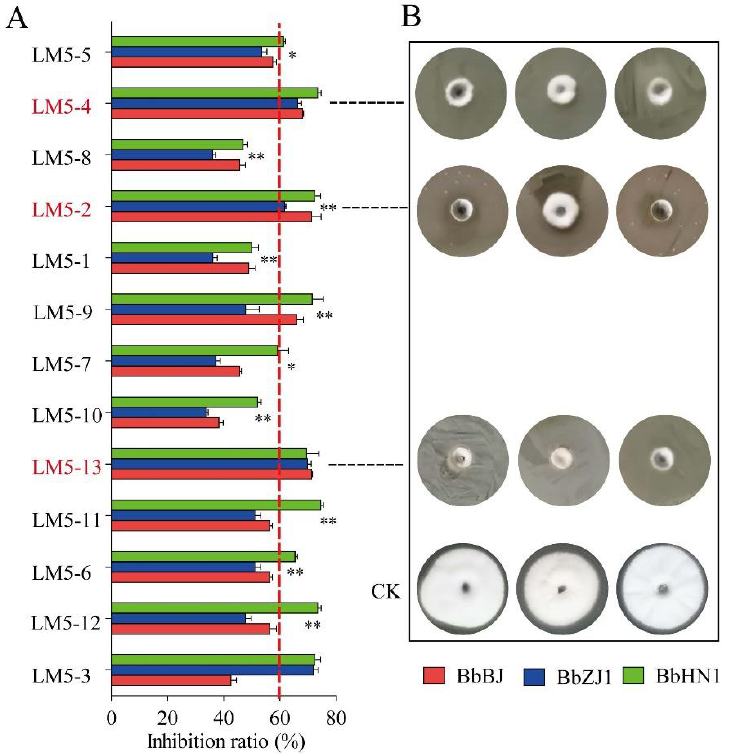
Figure 2. Inhibitory effect of migratory locust surface bacterium on B. bassiana . ( A ) Inhibition rates for B. bassiana strains by bacteria. Values (mean ± SE) with “*” or “**” are significantly different between strain BbZJ1 and other strains at a level of 0.05 or 0.01 (Kruskal – Wallis test). ( B ) B. bassiana colonies growing on medium coated with three of the recovered bacterial strains. CK: normal-growing and uninhibited fungal colonies.